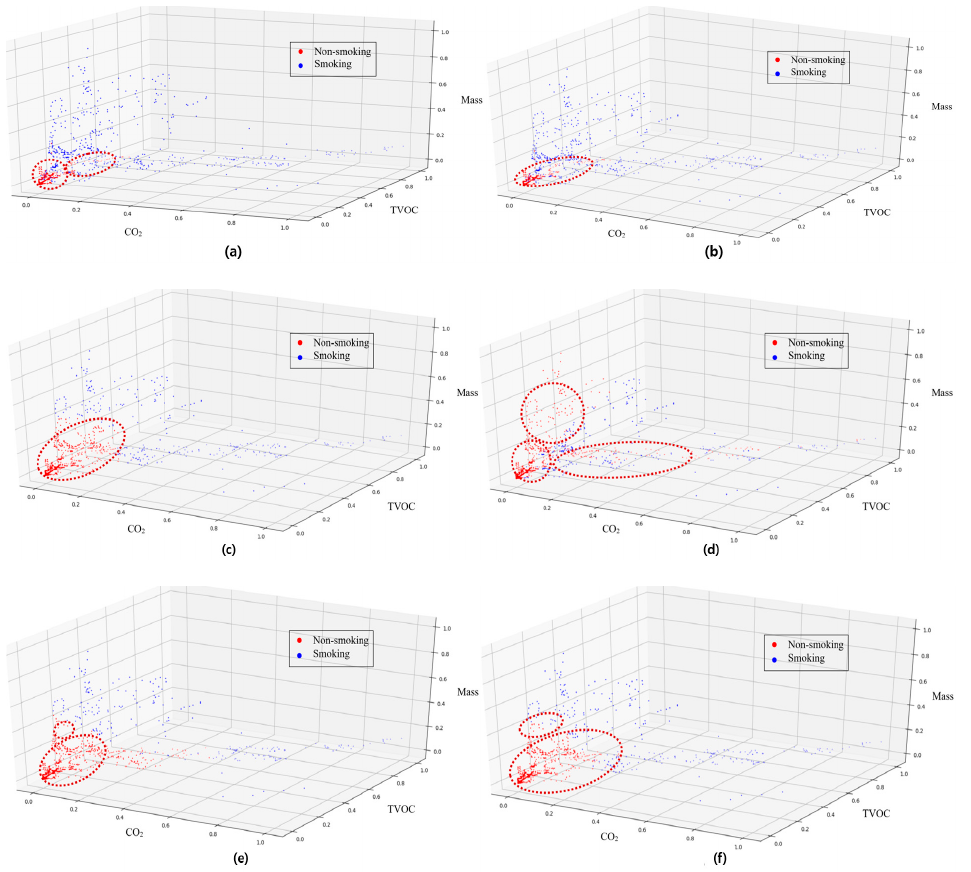
Figure 12. 3D Coordinate graph of ( a ) K-Means ( b ) PFCM ( c ) KNN ( d ) MLP ( e ) Linear SVM ( f ) SVM RBF